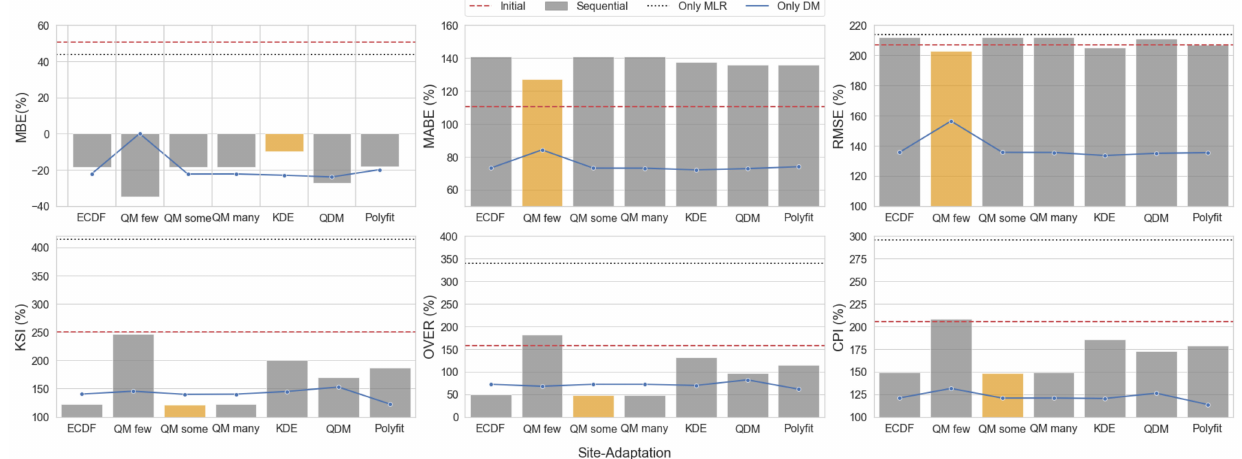
Figure 8. Same as Figure 6 but for DNI in the cloudy-sky